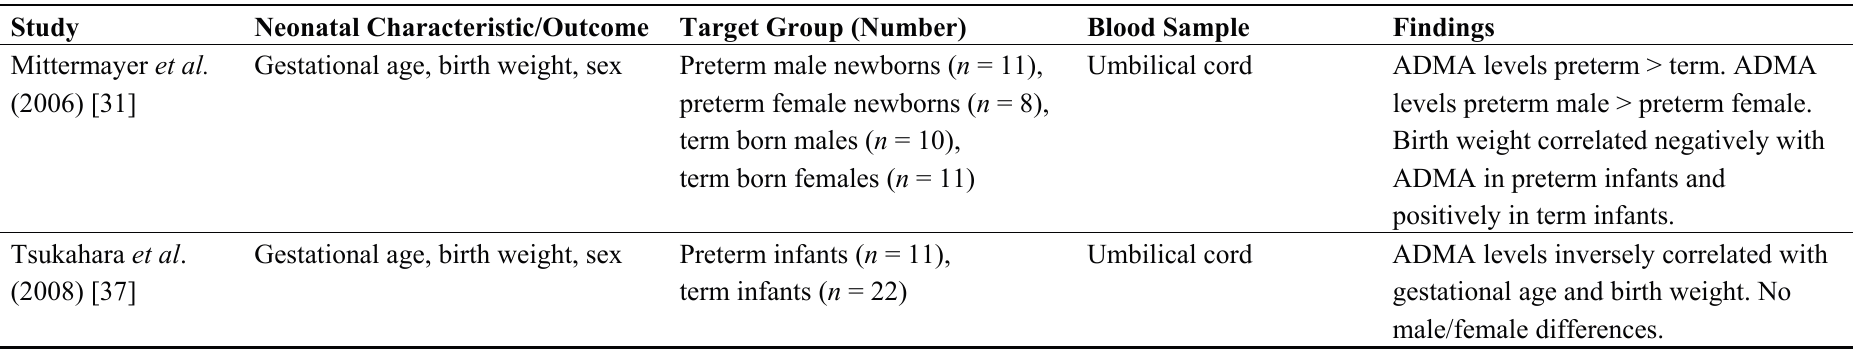
Table 7. Summary of studies describing the association between neonatal outcome and dimethylarginines in cord blood or plasma of infants.